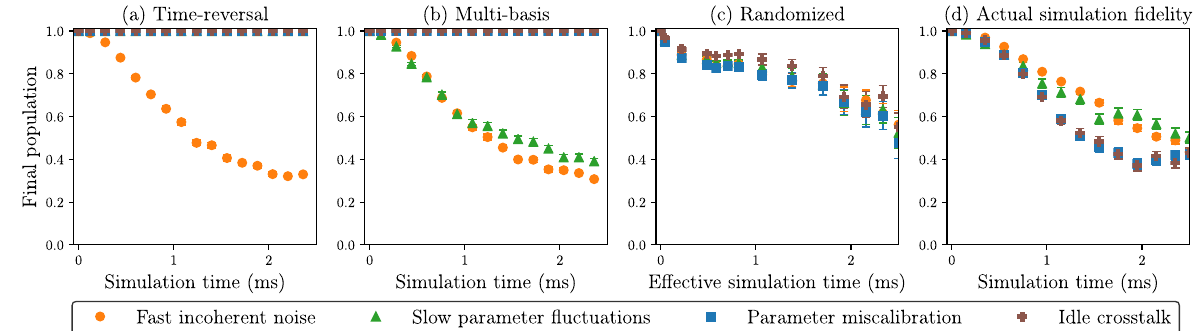
Fig. 7 Numerical fi ve-qubit simulation results of veri fi cation protocols under simulated noise conditions. Five-qubit numerical simulation results showing the sensitivities of each of the three analog veri fi cation protocols to four different types of experimental error sources: fast incoherent noise (~ τ / n ) in Hamiltonian parameters with 30% relative standard deviation (RSD), slow fl uctuations ( ≫ τ ) in Hamiltonian parameters with 15% RSD, constant miscalibration of Hamiltonian parameters with 10% RSD, and constant idle crosstalk affecting all sites with 10% RSD. The target Hamiltonian is the fi ve-qubit Heisenberg model from Eq. (32), with b ð i Þ ¼ J ð i ; j Þ simulation time'' is the average time for which each term of the Hamiltonian is enabled. Error bars indicate standard error of the mean. a Time- reversal analog veri fi cation results. Each data point represents the distribution of results over 50 runs. b Multi-basis analog veri fi cation results. Each data point represents the distribution of results over 50 runs. c Randomized analog veri fi cation results. Each data point represents the distribution of 10 different randomly generated sequences with n = 150 steps, with each sequence simulated 20 times. d Actual fi delity of the analog simulation under each type of